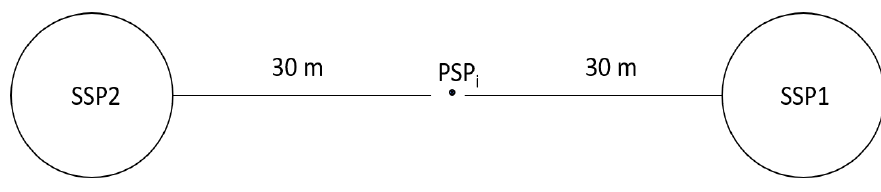
Figure 1. The sampling design of the permanent sampling plots